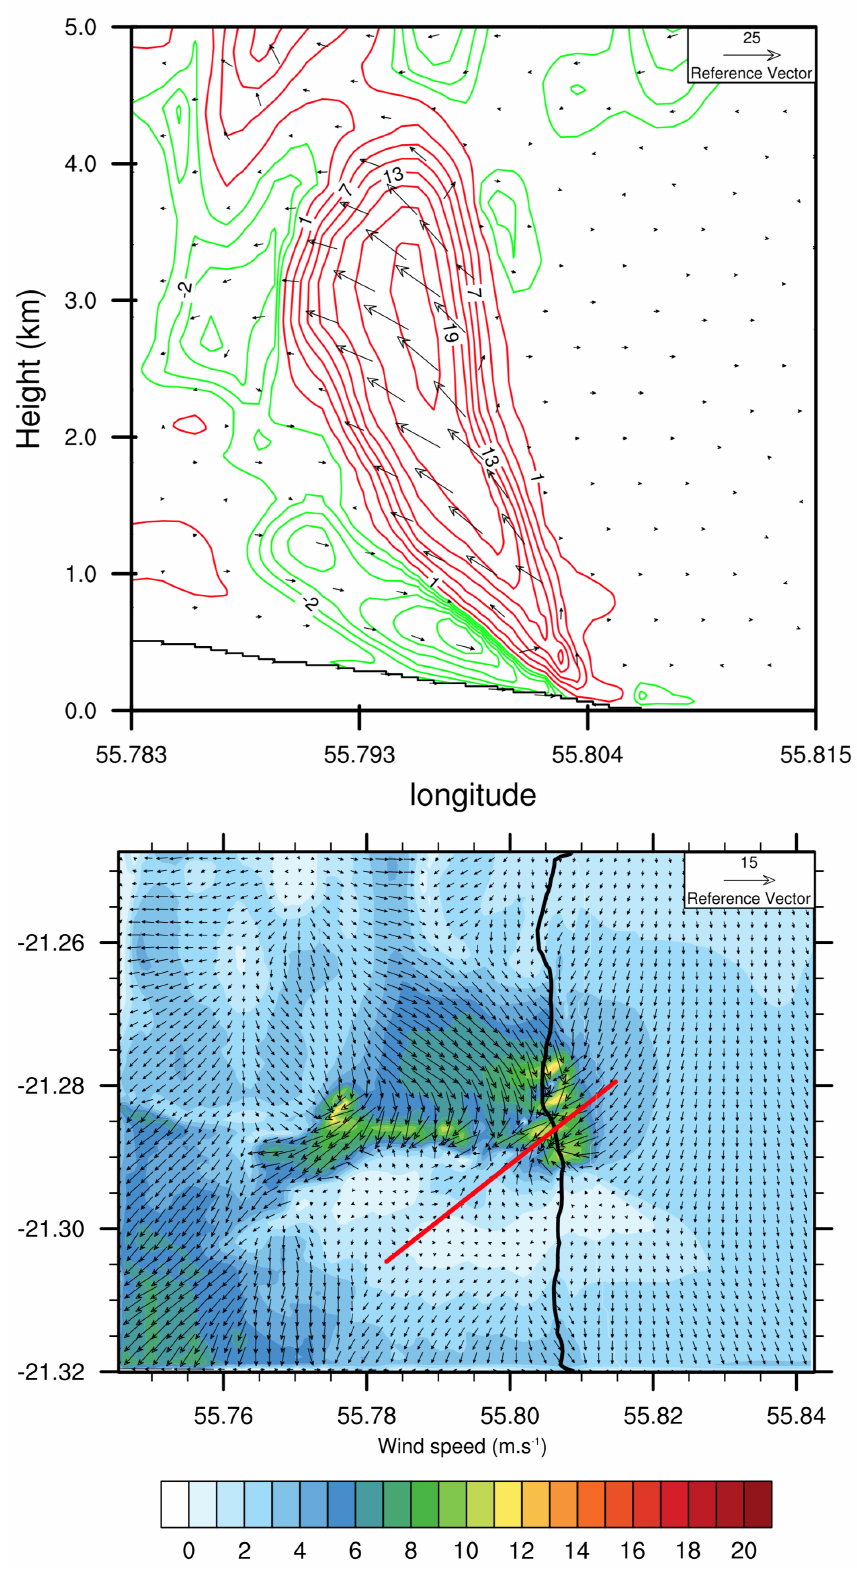
Figure 9. ( top ) Wind fields at the surface (color intensity in ms − 1 ) and wind arrows simulated by MesoNH on 6 April at 06 UTC. Positive vertical speeds are shown in red, negative vertical speeds in green, and potential temperature in black. ( bottom ) Vertical section of wind field difference (ms − 1 ) and temperature (K) between a simulation with lava and a simulation without